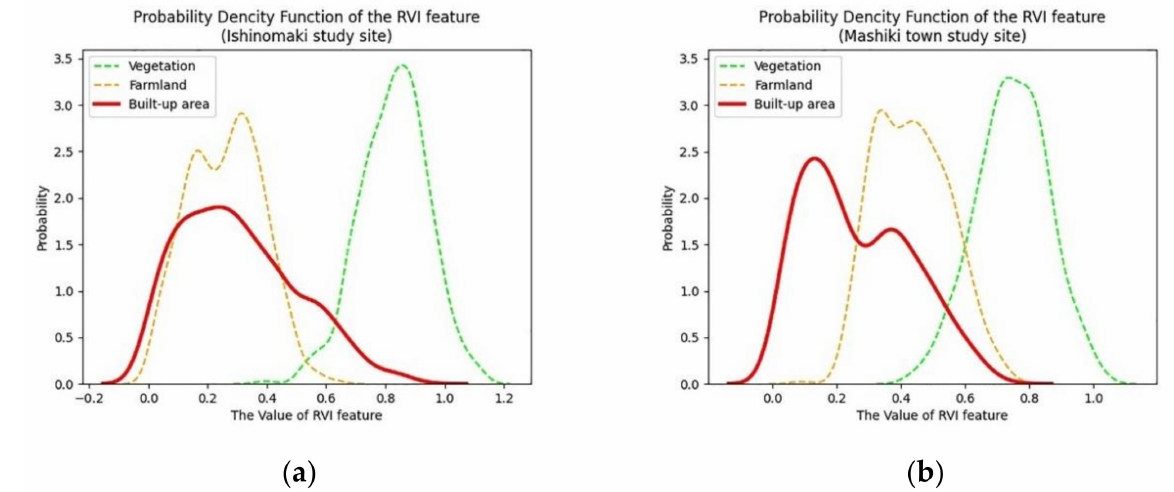
Figure 12. The pdf of the radar vegetation index (RVI) of mountain vegetation, farmland, and built-up area samples in different study sites: ( a ) Ishinomaki study site; ( b ) Mashiki town study site.